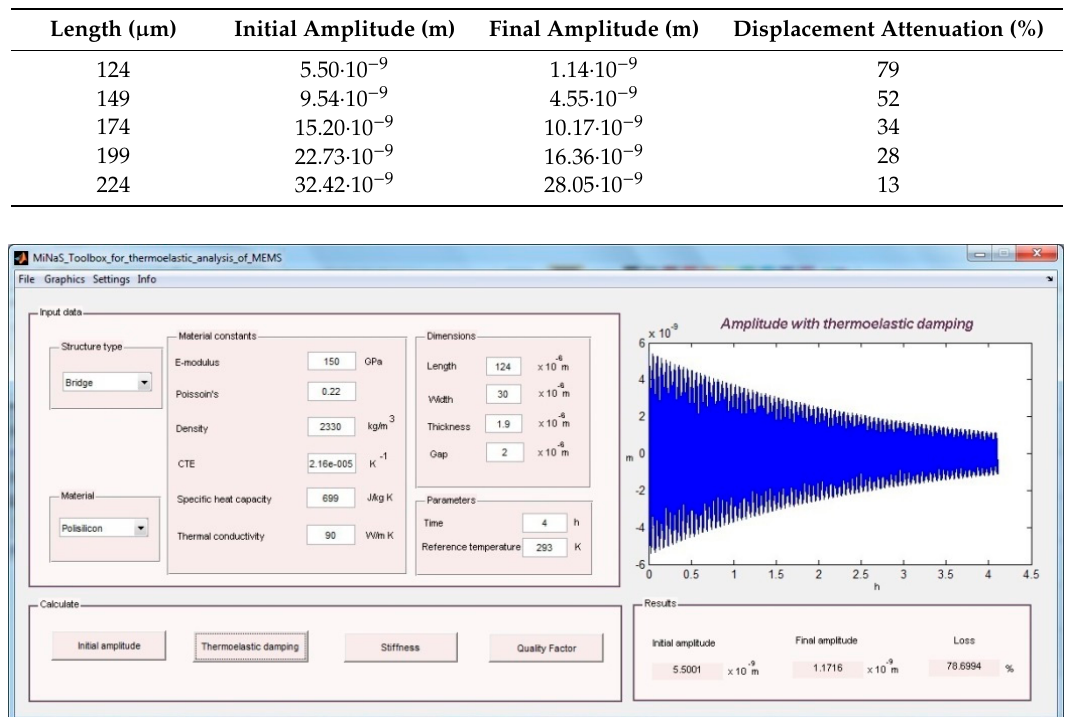
Figure 2. MiNas Toolbox GUI—used for a micro-resonator with L = 124 µm. Table 3. Analytical results for the investigated micro-bridges.